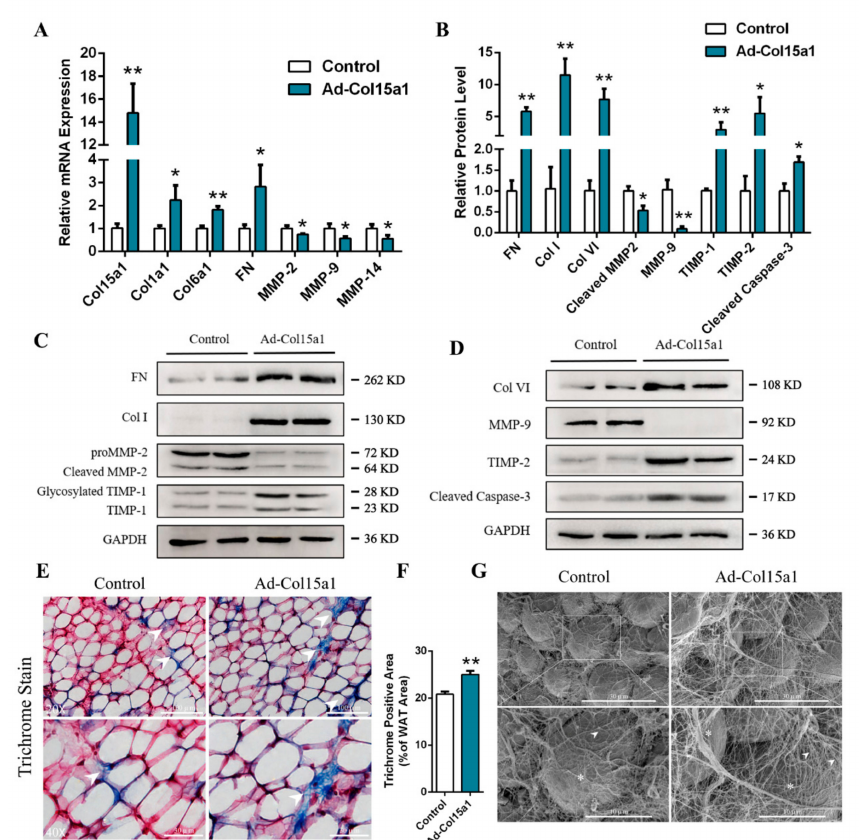
Figure 4. ColXV raised excessive deposition of ECM composition in WAT. All mice were pretreated with either Ad-GFP or Ad-Col15a1. ( A ) Relative mRNA expressions of Col15a1, Col1a1, Col6a1, Fibronectin, MMP-2, MMP-9 and MMP-14 in mice inguinal white adipose tissue (iWAT) ( n = 6). ( B – D ) Relative protein expressions of Fibronectin, Col I, Col VI, MMP-2, MMP-9, TIMP-1, TIMP-2 and Cleaved Caspase-3 in mice iWAT ( n = 6), each group has two technical repeats. ( E – F ) Representative images of Masson’s trichrome staining (collagen is shown as blue, nuclei as black and cytoplasm as red) in frozen-section iWAT samples. Scale bar, 100 µ m (top) and 30 µ m (bottom) ( n = 4). Arrowheads indicate thinner collagen fibers (left) and thicker collagen fibers (right). ( G ) Representative images of collagen bundles microstructure on adipocytes surface by scanning electron microscope. Scale bar, 30 µ m (top) and 10 µ m (bottom) ( n = 4). Arrowheads indicate thinner collagen bundles (left) and thicker collagen bundles (right). Asterisks indicate adipocytes. Values are presented as mean ± SEM. * p < 0.05, ** p <